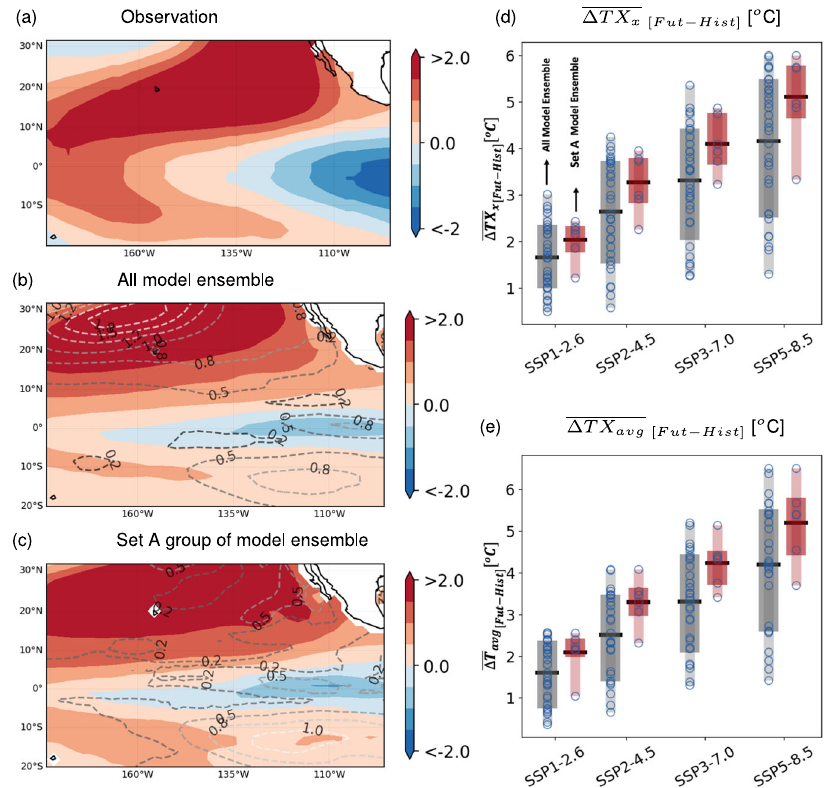
Fig.4|RepresentationofPaci fi cMeridionalMode(PMM)inthestate-of-the-art CMIP6 climate model simulations and their implications on the future pro- jections of heatwaves. The leading coupled mode of SST and surface winds over the core PMM region, obtained from the maximum co-variance analysis (see Methods).Fordepiction,weshowthespatialpatternsofSSTexpansioncoef fi cient for a observationaldataandtheensemblemeanofall b andSetAmodel/realization simulations ( c ). The contours in b and c represents the standard deviation of the SSTleadingmodeamongsttheensemblemembers.ReferrelatedtextsinMethods for more details on the criteria for grouping the considered CMIP6 models. The